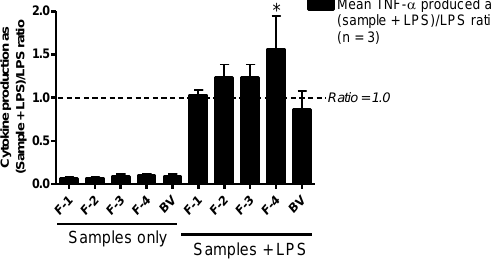
Figure 4. Effect of bee venom and its fractions of TNF-α production in PMA-differentiated U937 cells. All five samples tested produced slightly more than background levels of TNF-α, but not significantly different from those of the negative control (media). The level of TNF-α was significantly higher in fractions co-stimulated with F-4 and LPS compared to LPS, but the other fractions did not show any significant changes in the levels of the cytokine ( n = 3).